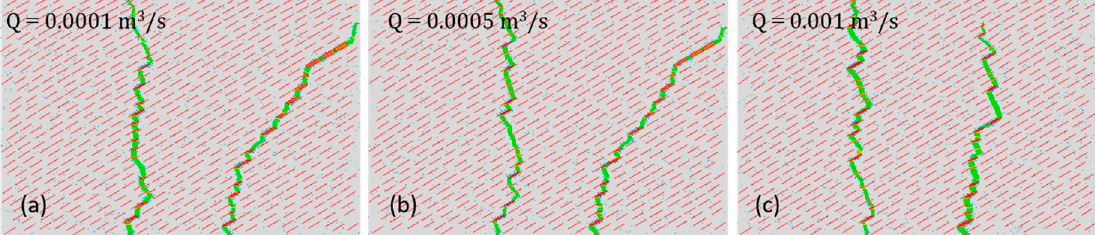
Figure 12. Effect of fluid rate on hydraulic fracture propagation. ( a ) Injection rate = 0.0001 m 3 /s; ( b ) injection rate = 0.0005 m 3 /s; ( c ) injection rate = 0.001 m 3 /s.